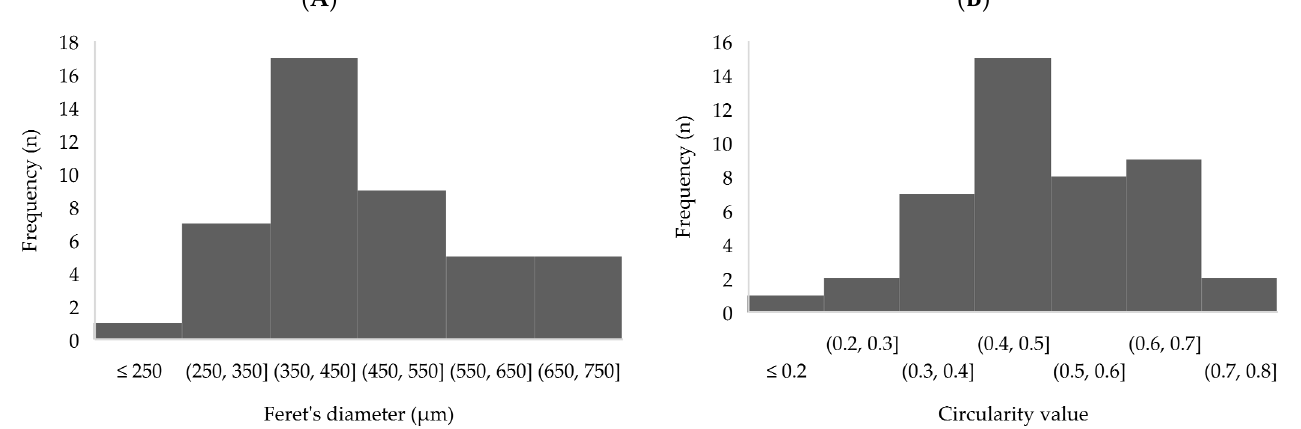
Figure 2. Histograms of the obtained Image J (Bethesda, MD, USA) results from Figure 1 image: ( A ) Feret’s diameters and ( B ) circularity values, where 1 refers to a perfect circle shape and values near 0 refer to elongated shapes.